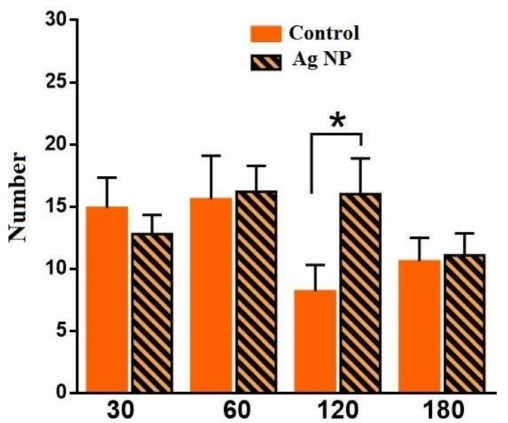
Figure 9. Number of rearings for different periods of the experiment. The reliable difference can be seen for 120